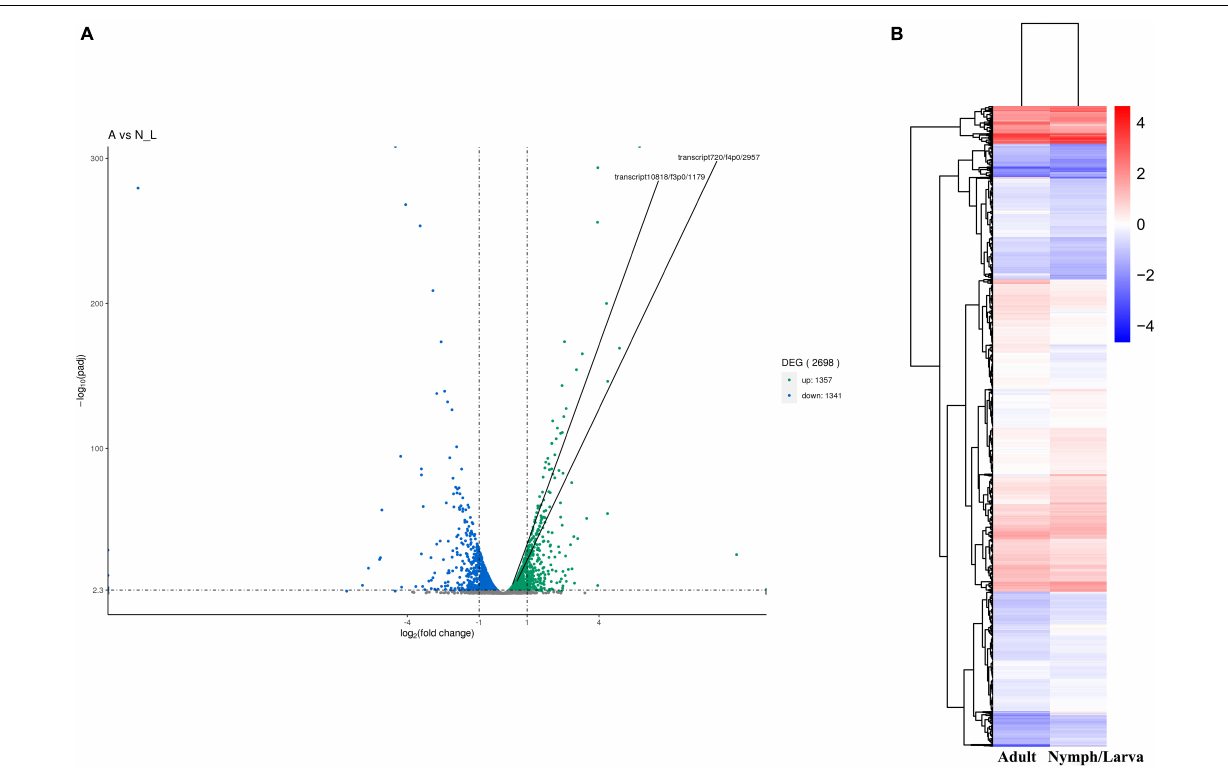
the R 2 values of all six samples. The average correlation of